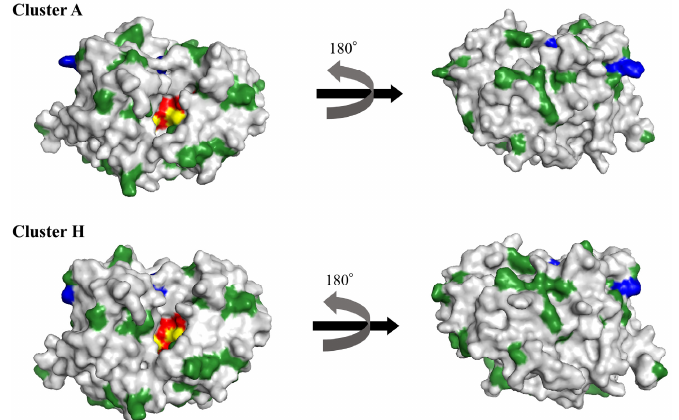
Figure 3. PDC structural models of the representative samples selected from clusters A and H. The active sites on the proteins are colored red. Positive and negative selection sites are shown in blue and dark green, respectively. The superimposed sites between active sites and negative selection sites are indicated in yellow.